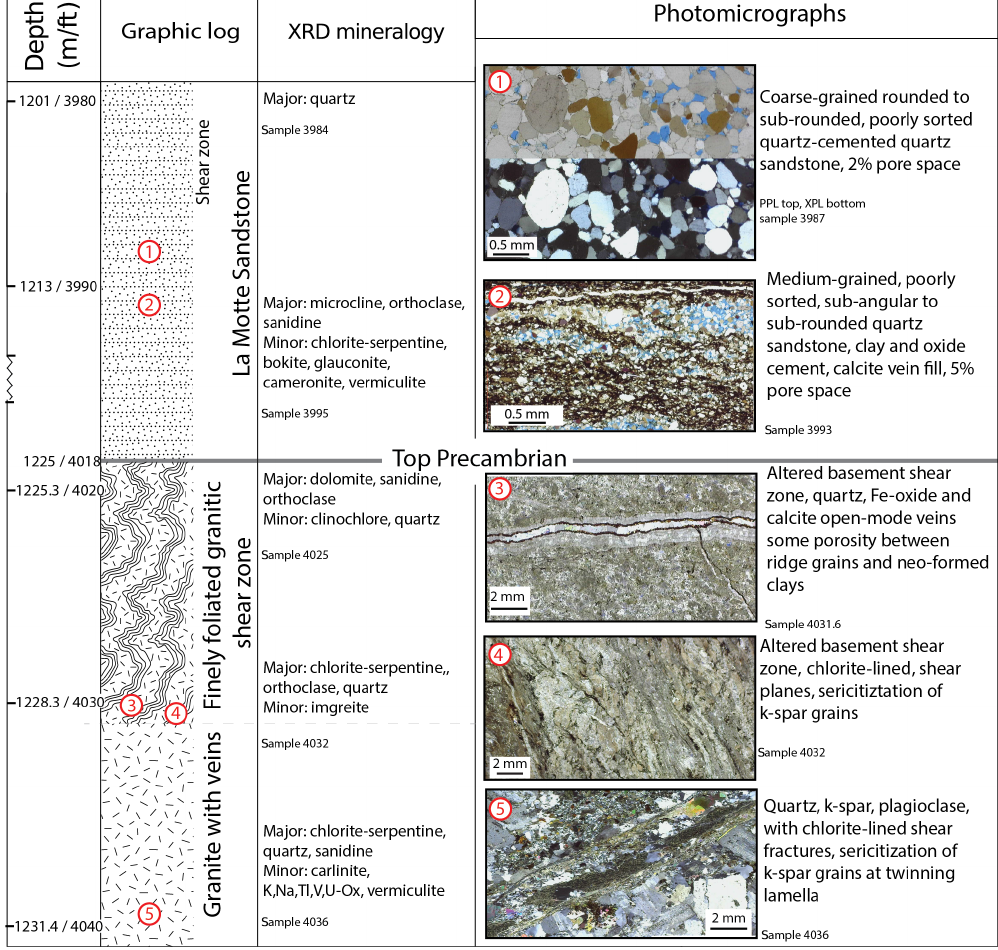
Figure 9. Petrographic summary, photomicrographs, and X-ray diffraction results of nonconformity units studied in the R.C. Taylor 1 core; (a) La Motte Formation sandstone, rounded to sub-rounded, poorly sorted quartz sandstones (100 × , ppl and xpl); (b) lower La Motte For- mation, opaque Fe-oxide cements and vein fill, porosity shown by blue epoxy, (100 × ppl); (c) top Precambrian crystalline altered basement shear zone. Syntaxial veins are mineralized with quartz, reactivated, and mineralized with Fe-oxide then sparry calcite. There is some poros- ity between rigid grains and neo-formed clays (50 × PPL); (d) altered basement shear zone, chlorite-lined shear planes, sericitization of feldspars along twining lamella (100 × ppl); (e) coarse-crystalline sericitization of feldspars adjacent to twin lamellae (150 ×